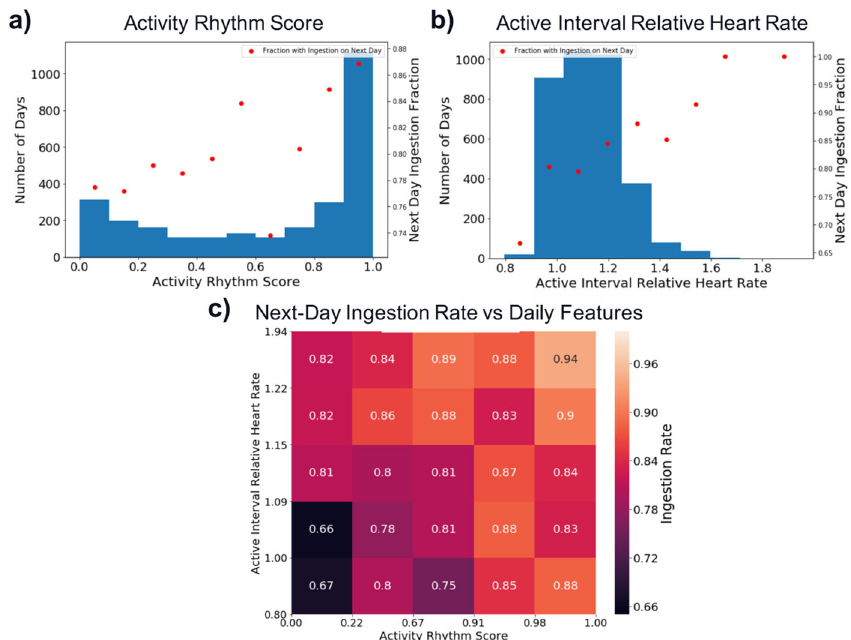
Fig. 4 Daily AR and rHR Features vs next-day ingestion. a Histogram of AR values for all analyzable days. The red dots represent the fraction of days within each bin that are followed by successful ingestion on the next day. Note that the next-day ingestion rate seems to be higher for days with higher AR values. b Histogram of rHR values for all analyzable days. The red dots represent the fraction of days within each bin that are followed by successful ingestion on the next day. Note that the next-day ingestion rate seems to be higher for days with higher rHR values. c Heatmap of next-day ingestion rates as a function of both AR and rHR . The analyzable days are sorted into bins based on their AR quintile ( x axis) and rHR quintile ( y axis), and the color of the heatmap represents the fraction of days in each bin that are followed by successful ingestions on the next day. Note that the values on the x and y axes represent the limits of each quintile for the features. Higher values of both AR and rHR seem to be associated with higher next-day ingestion rates.